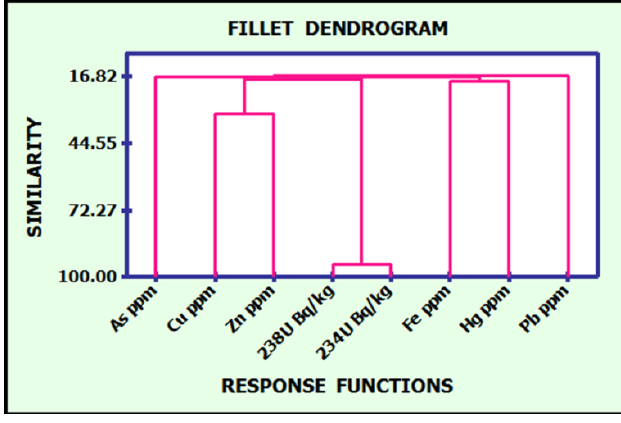
Figure A1. Dendrogram of similarities of response functions in fillet samples.